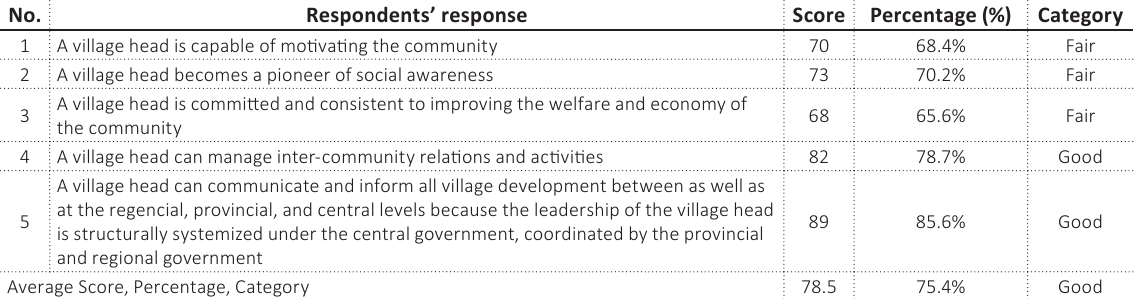
Table 4. Strategy indicators in mapping soft skills of characteristics and potential development of village community in Bilato